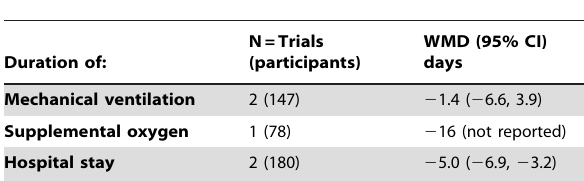
Table 7. Duration of care and